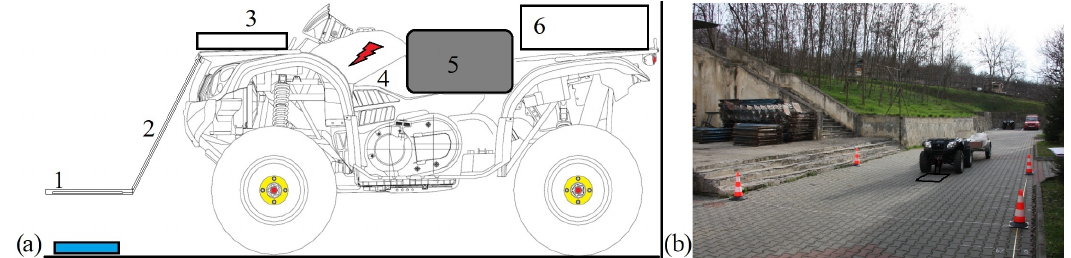
Figure 11. Simplified schematic ( a ) of the experimental proposed ATIRV ( b ) consisting of the following main components: (1) front sensor; (2) sensor support; (3) conversion board and wire assembly